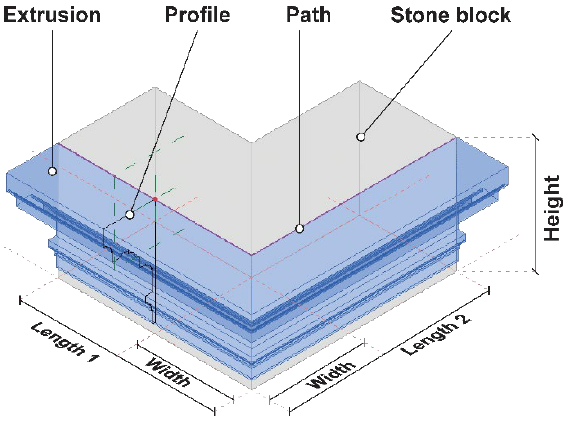
Figure 2: Anatomy of an angular parametric